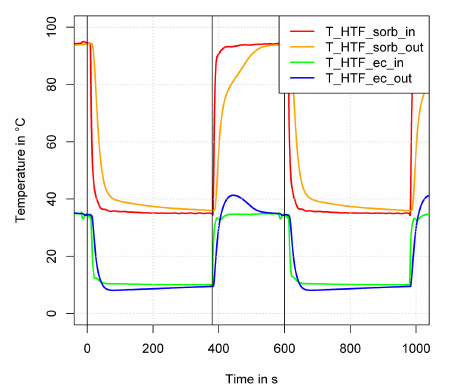
Figure 6. Temperature curves of the adsorption heat exchanger in/out and evaporator/condenser in/out. Temperature boundary conditions are 10/35/95 ◦ C, 400 s adsorption, 200 s desorption half cycle time, volume flow rate is kept constant at 10 L/min for each heat exchanger throughout the whole